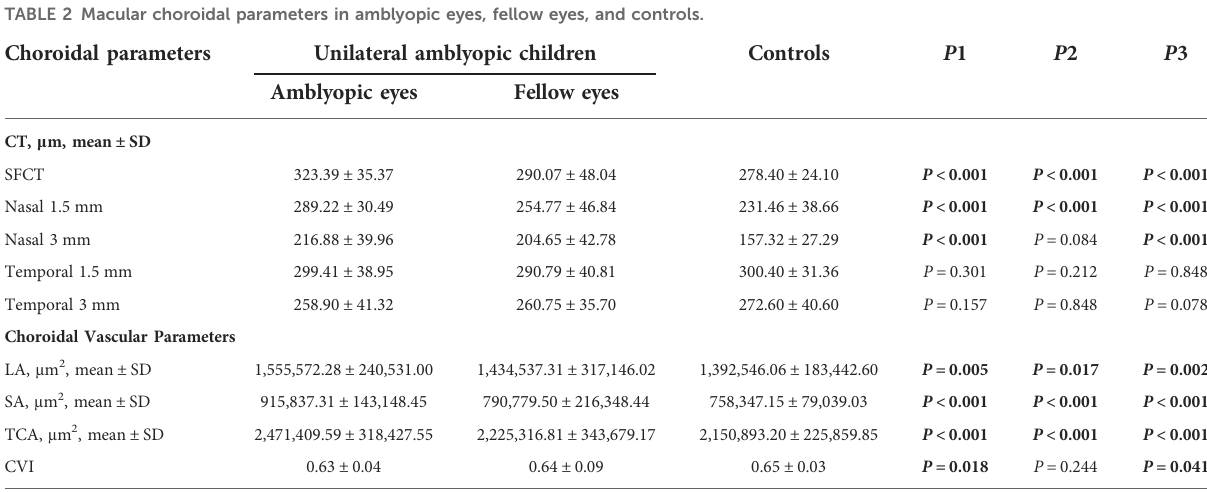
TABLE 2 Macular choroidal parameters in amblyopic eyes, fellow eyes, and controls. Choroidal